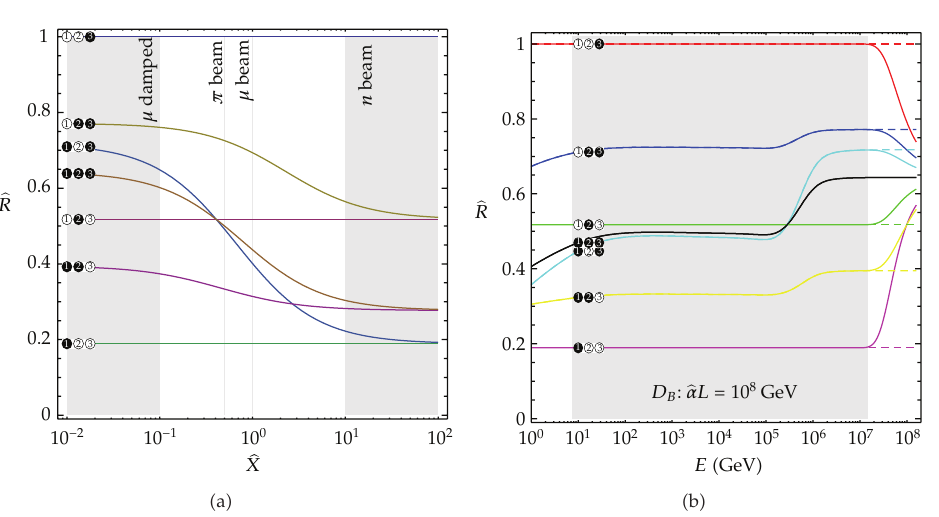
(cid:19) R Figure 9: (cid:3) a (cid:4) as a function of the initial flavor composition decays (cid:4) , where filled disks correspond to stable mass eigenstates and unfilled disks to unstable mass (cid:19) R eigenstates. (cid:3) b (cid:4) as a function of energy for a pion beam to muon damped source (cid:3) cf. Figure 5, TP 13 (cid:4) for a specific decay parameter (cid:3) same for all unstable states (cid:4) , as given in the panel. The dashed curves stand for complete decays, figures adopted from (cid:5) 100 (cid:6)